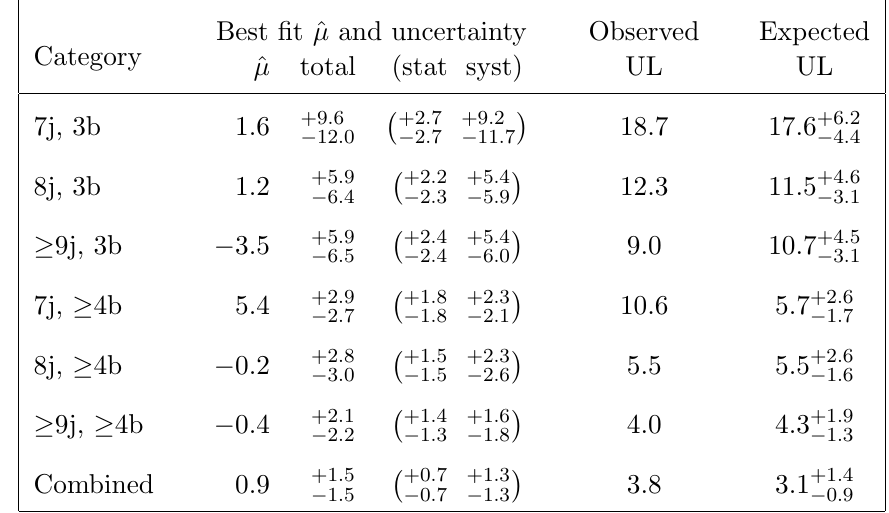
Table 6 . Best (cid:12)t value of the signal-strength modi(cid:12)er ^ (cid:22) and the median expected and observed 95% CL upper limits (UL) on (cid:22) in each of the six analysis categories, as well as the combined results. The best (cid:12)t values are shown with their total uncertainties and the breakdown into the statistical and systematic components. The expected limits are given together with their 68% CL intervals.